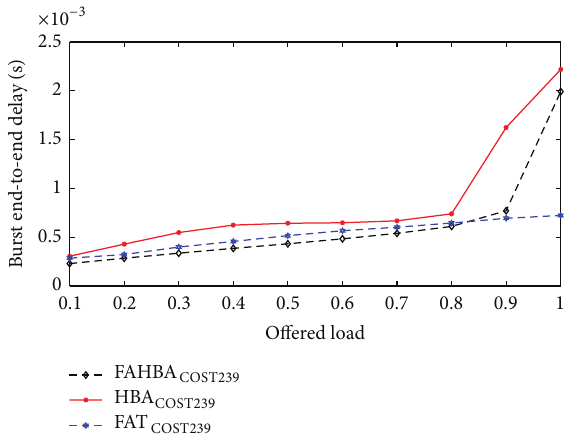
Figure 6: Packet loss ratio versus offered load.